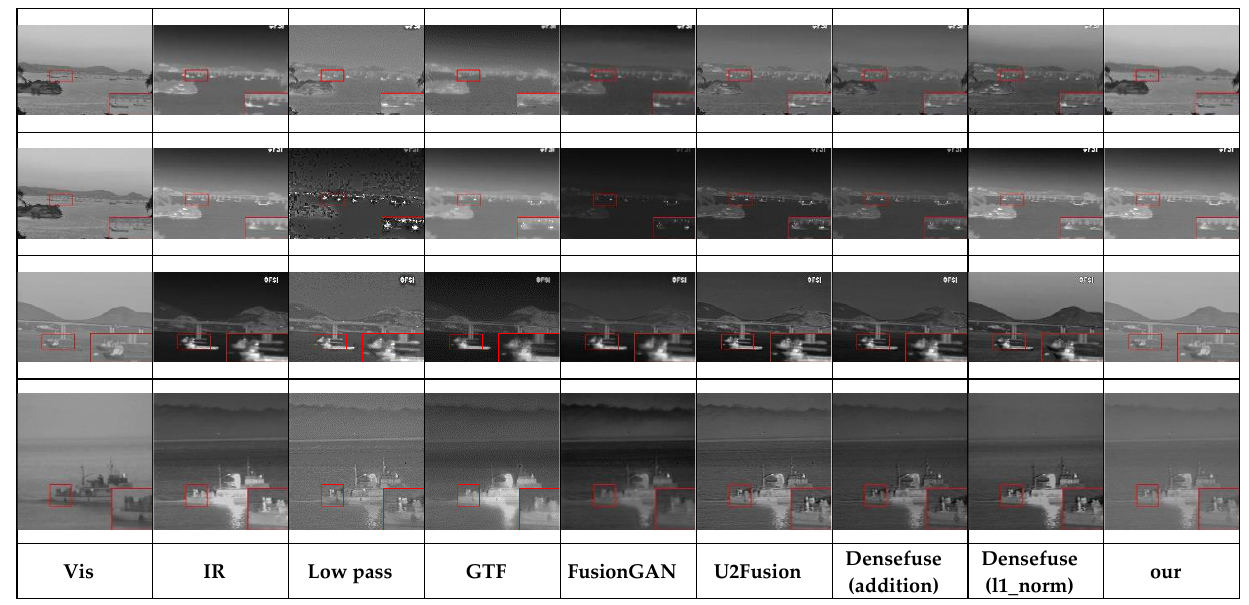
Figure 6. Qualitative comparison of our method with 6 state-of-the-art methods on 4 typical marine image pairs. The first three pairs of test images are from the Visible-Infrared Database [32], and the last pair is from TNO . For a clear comparison, we use a red box to select a small area in each image and zoom in it in the bottom right corner.